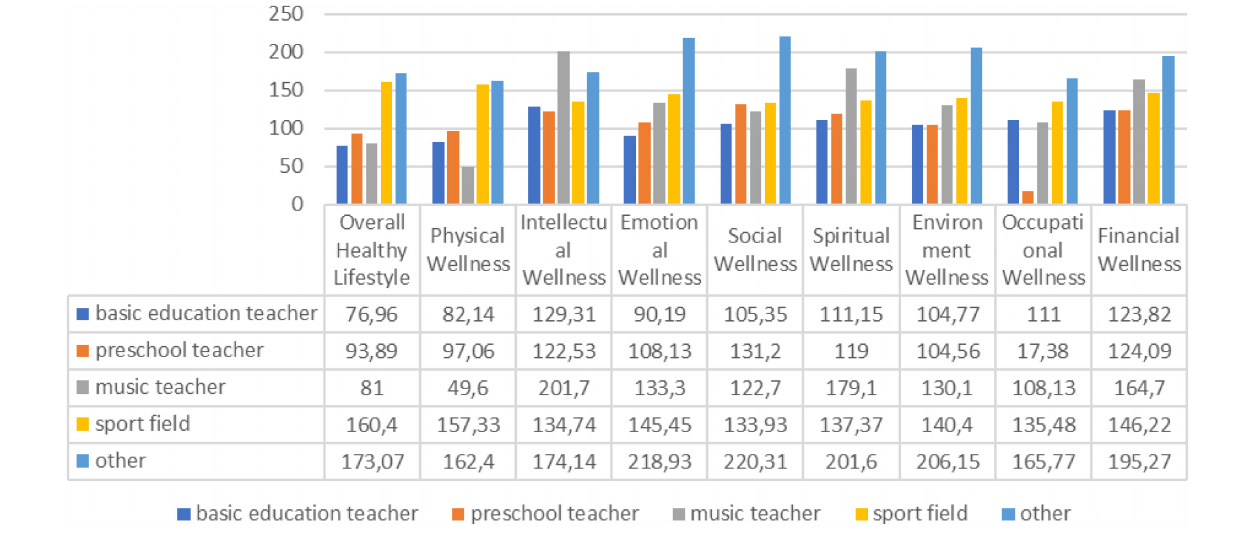
FIGURE 1 | Mean ranks of the different wellness dimensions by respondent’s field of study.